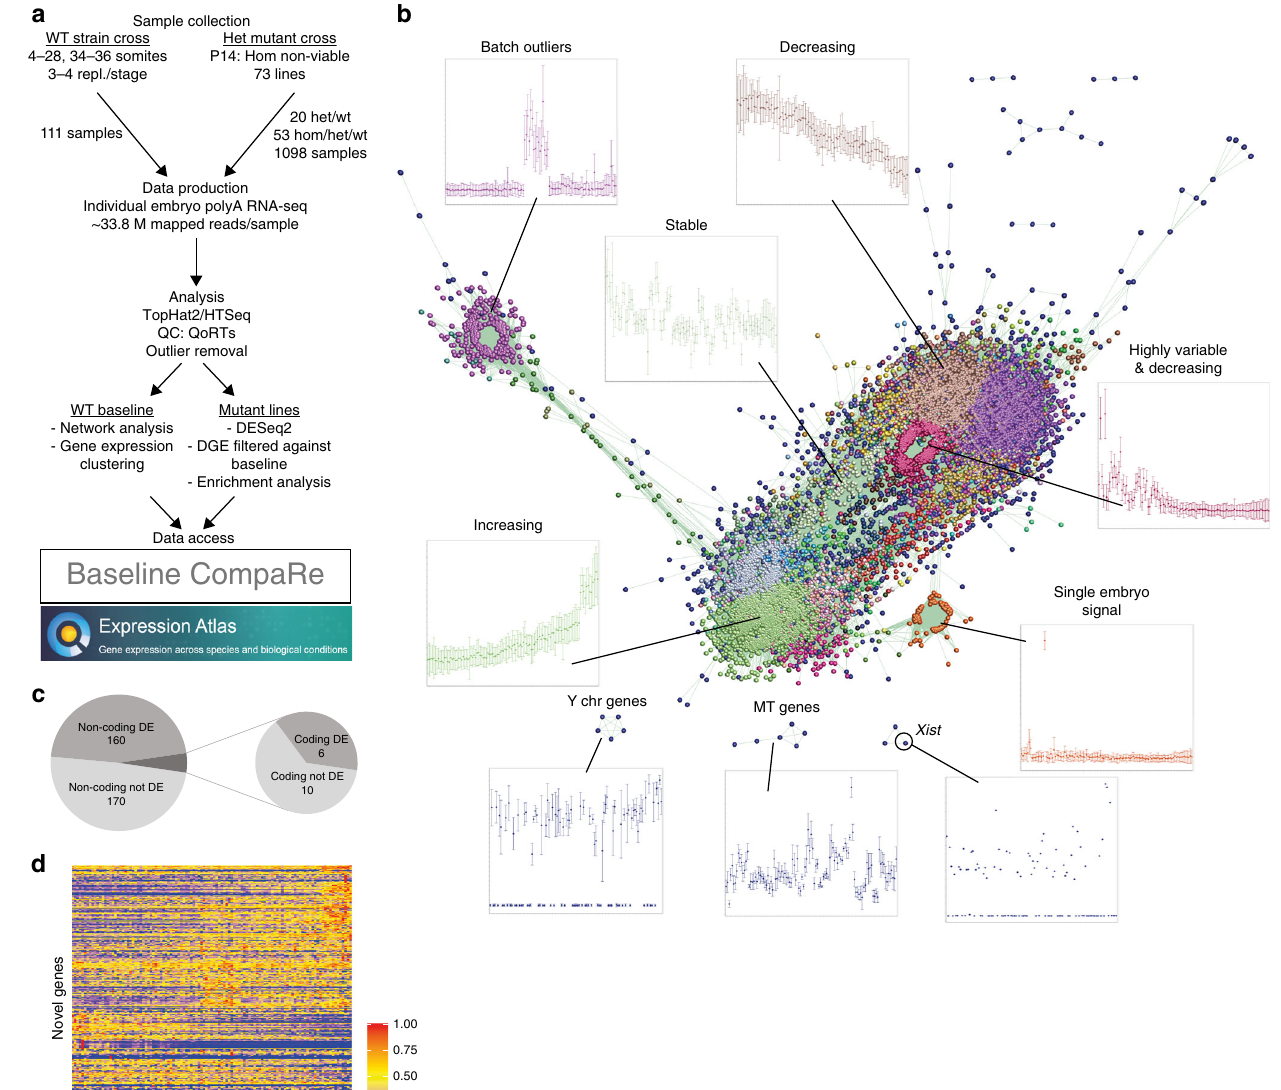
Fig. 1 Experimental strategy and data processing. a Experimental work fl ow for E9.5 baseline and mutant line analysis. For the baseline, wild-type mice from heterozygous incrosses generated as part of the DMDD project were outcrossed (WT strain cross) and embryos from these crosses were collected. This was to produce embryos with a similar genetic background to the mutants. For the mutant lines, embryos were obtained from heterozygous intercrosses (Het mutant cross). The processed data can be viewed using Baseline CompaRe. The baseline data are available in Expression Atlas. b Clustered gene expression network identi fi es co-expressed genes across the baseline samples. The gene expression data are displayed using BioLayout Express 3D as a network of genes (nodes) with edges connecting nodes whose expression values over all the samples have a Pearson correlation coef fi cient of ≥ 0.85. Nodes represent 9265 genes and are coloured according to Markov clustering (MCL). Surrounding graphs show expression of genes in a selection of clusters with individual embryos ordered by somite number on the x -axis, and gene expression in the cluster (unit variance scaled with standard deviation) on the y -axis. Batch outliers (top left) are genes that were blacklisted from further analysis. Decreasing/increasing genes are the ones most indicative of stage as they change the most across the time course, whereas the cluster labelled Stable is more consistent. Highly variable and decreasing is a set of genes that have high variance even among embryos at the same stage. Single embryo signal is a cluster of genes that are expressed at high levels in just one embryo. Xist , Y chr genes and MT genes (genes encoded by the mitochondrial chromosome) were removed due to high variability. c Venn diagram of the categories of novel (previously unannotated) genes identi fi ed using all RNA-seq data across all embryos. d Heatmap of expression pro fi les of the novel genes. Each row is a gene and each column a sample in somite number order. In each row, expression data are scaled to the maximum value (set to 1) for that row. The genes are ordered by hierarchical clustering. Source data are provided as a Source Data fi